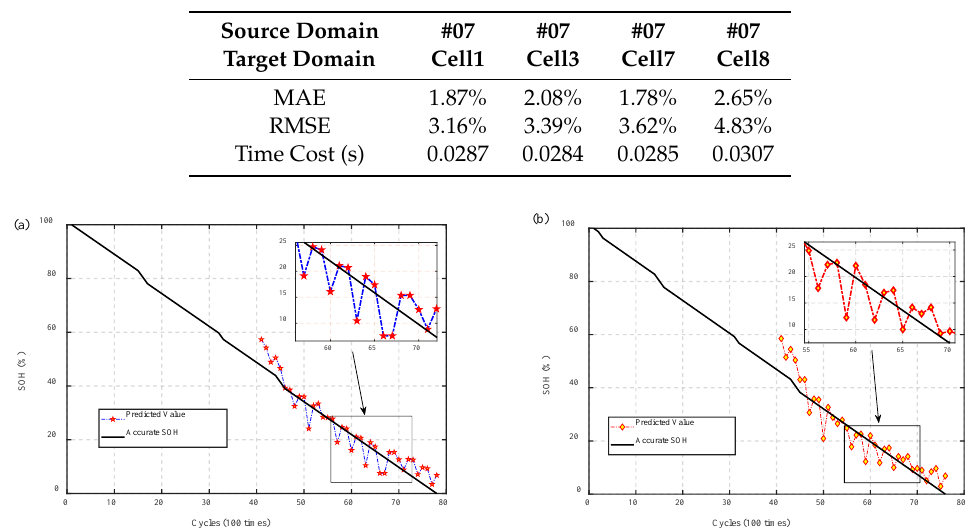
Table 3. Prediction results between Battery #07 and Cell1, Cell3, Cell7, and Cell8.